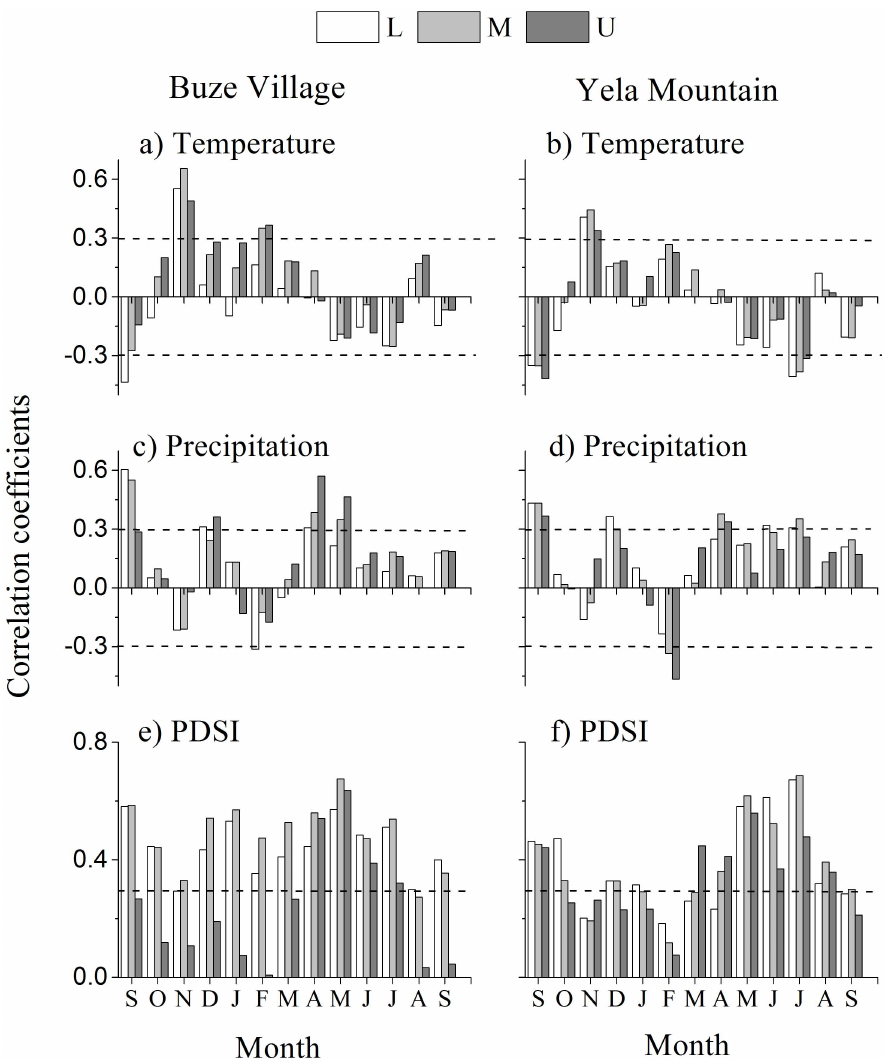
Fig 6. Correlation coefficients between the tree-ring chronologies of different elevation and monthly climatic factors in Buza and Yela Mountains. Monthly climatic factors are from September of the prior growth year to September of the current growth year. The dotted lines represent significanceat the level of p < 0.05. L, M, and U represent the lower, middleand upper